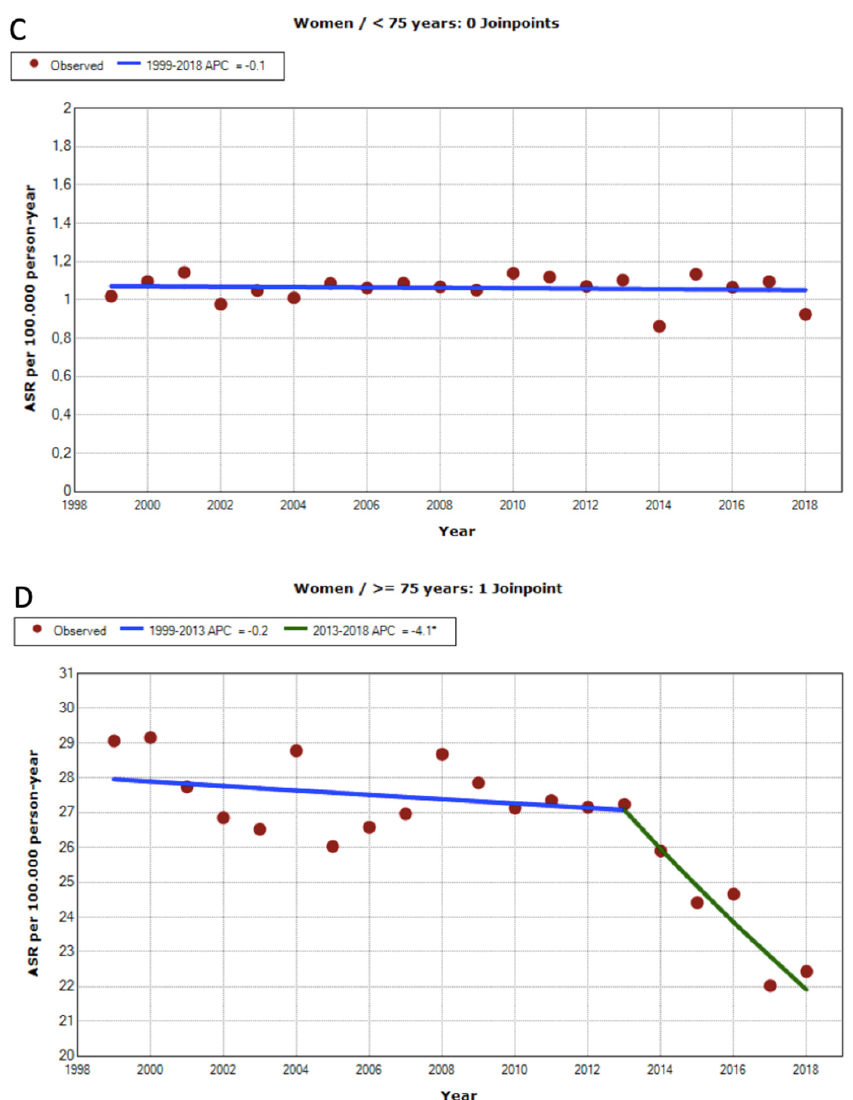
Figure 1. Premature mortality trends due to BC for the period 1999 ‐ 2018 in Spain: ( A ) men < 75 years old (Final Selected Model = 1 Jointpoint); ( B ) men ≥ 75 years old (Final Selected Model = 1 Jointpoint); ( C ) women < 75 years old (Final Selected Model = 0 Jointpoint); and ( D ) women ≥ 75 years old (Final Selected Model = 1 Jointpoint). * Indicates that the Annual Percent Change (APC) is significantly different from zero at the alpha = 0.05 level.